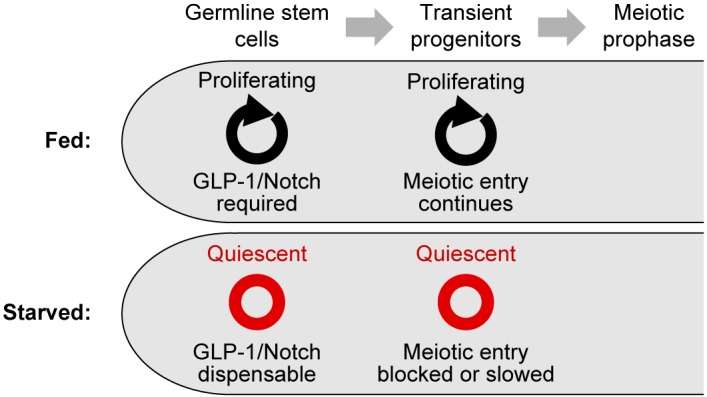
Summary of the effects of starvation on germ cell division, stem cell maintenance, and meiotic entry.Under fed conditions, mitotic cell divisions occur throughout the progenitor zone (Crittenden et al., 2006; Maciejowski et al., 2006); GLP-1/Notch is required for stem cell maintenance (Austin and Kimble, 1987); and transient progenitors enter the meiotic cell cycle if their movement out of the progenitor zone is restricted (Cinquin et al., 2010). Under starved conditions, germ cells become quiescent; GLP-1/Notch is dispensable for stem cell maintenance; and the meiotic entry of transient progenitors is slowed or blocked.